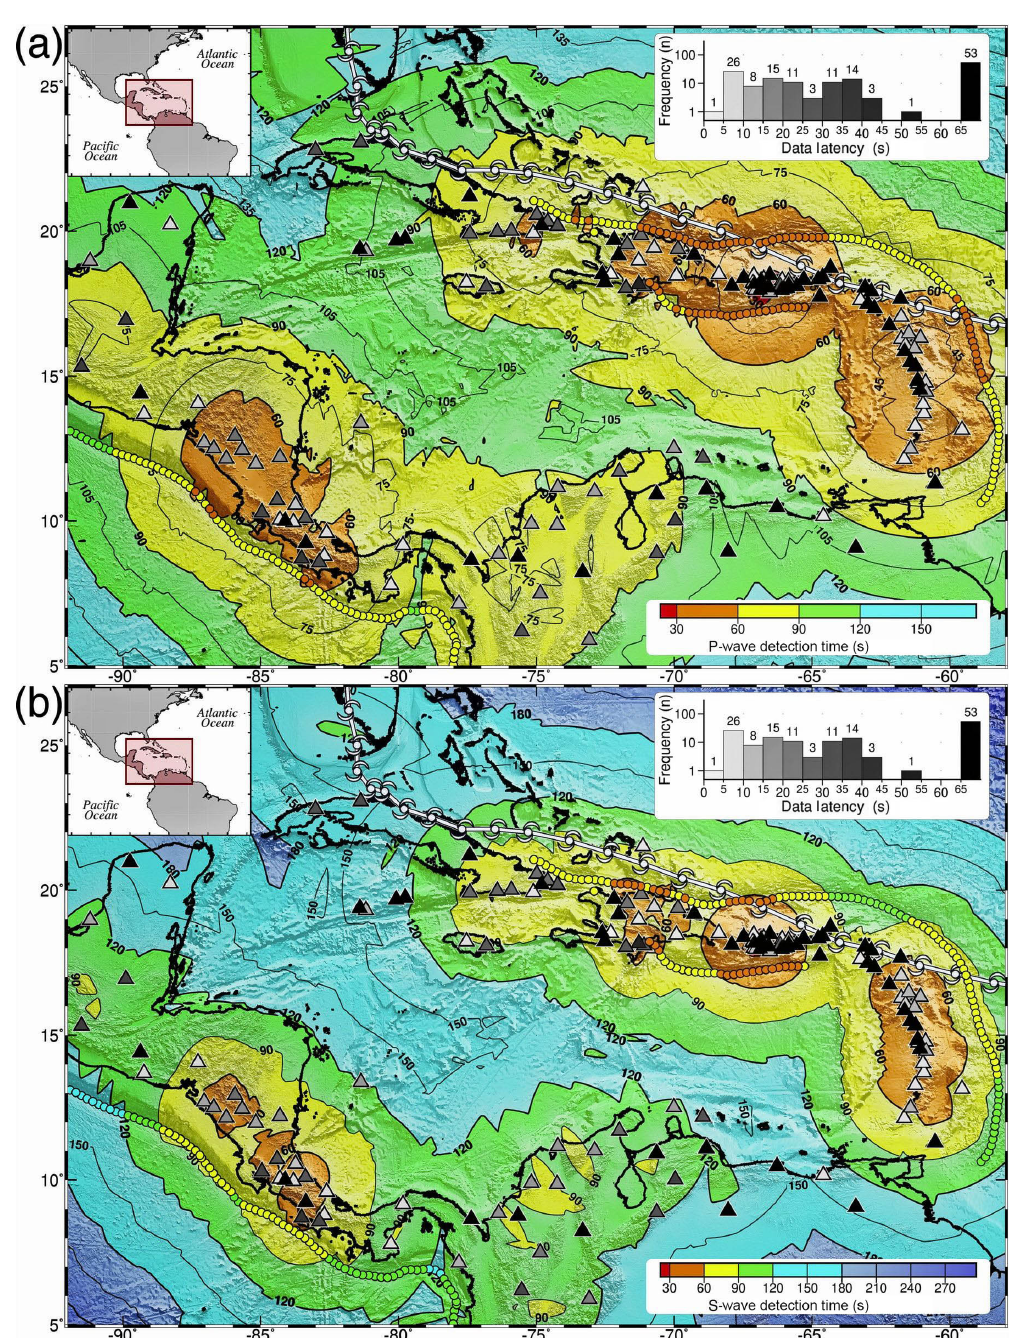
Figure 5. Theoretical detection time of the first arriving P and S waves in the Caribbean after hurricane Irma on 10 September 2017. The 19 additional station outages attributed to Hurricane Irma now add up to 36% (53 black triangles) of the 146 stations. These outages in turn reduced the 90 (yellow), 60 (orange), and 30s (red) detection areas to (a) 47%, 11.5%, and 0.16% of the total area for P wave detection and (b) 19.3%, 4.8%, and 0.1% of the region for S wave detection. The small, contiguous circles show the computed detection times sampled every 25km along the trench axes. White vortex tracks show the path of hurricane